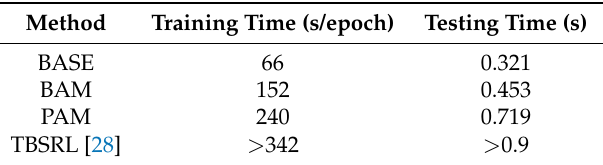
Table 7. Time performances of different